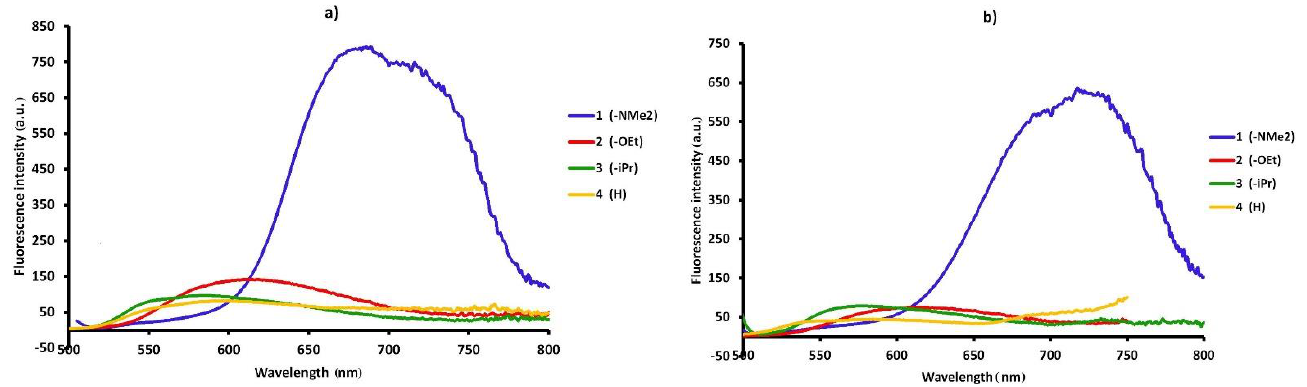
Figure 4. Fluorescence intensity spectra of 1 – 4 in dichloromethane ( a ) and in acetonitrile ( b ) (5 × 10 −5 M).